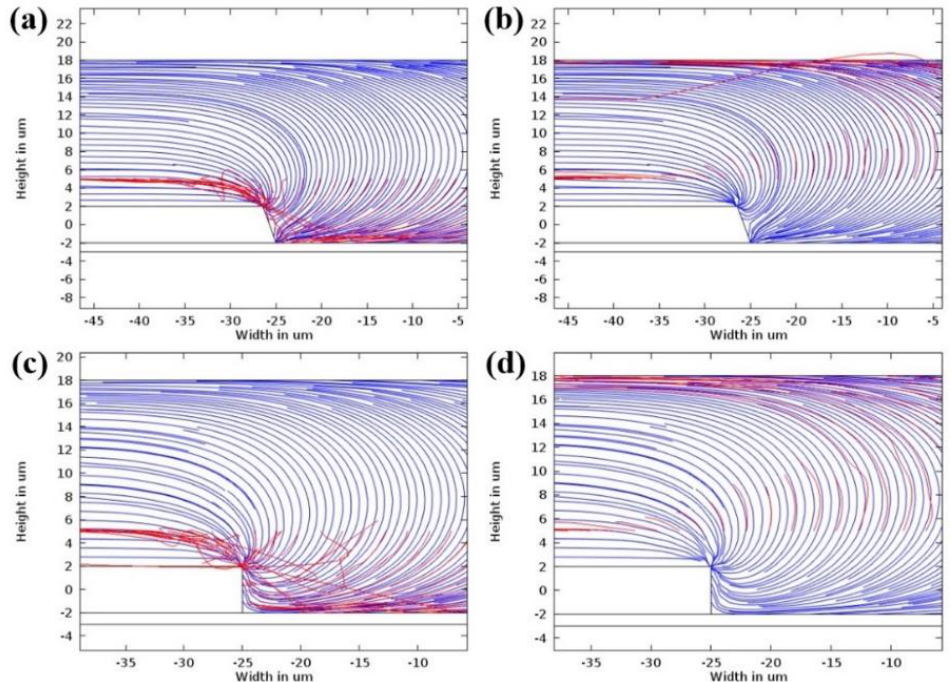
Figure 5. The FEM analysis of the particle trajectory for P DEP and N DEP , ( a , b ) the tapered microelectrode 70 ° and ( c , d ) the straight-cut 90 ° microelectrodes.